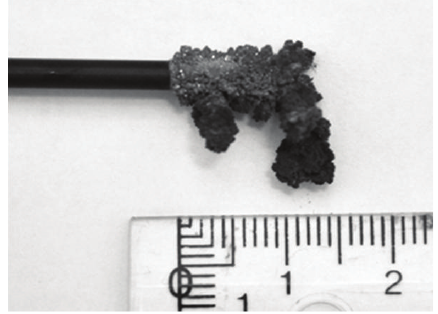
Figure 4: Copper metal from electrodeposition from the synthetic solution (Solution 1), containing copper(II), indium(III), and gal- lium(III) in 1M HCl, using a potential of − 0.5